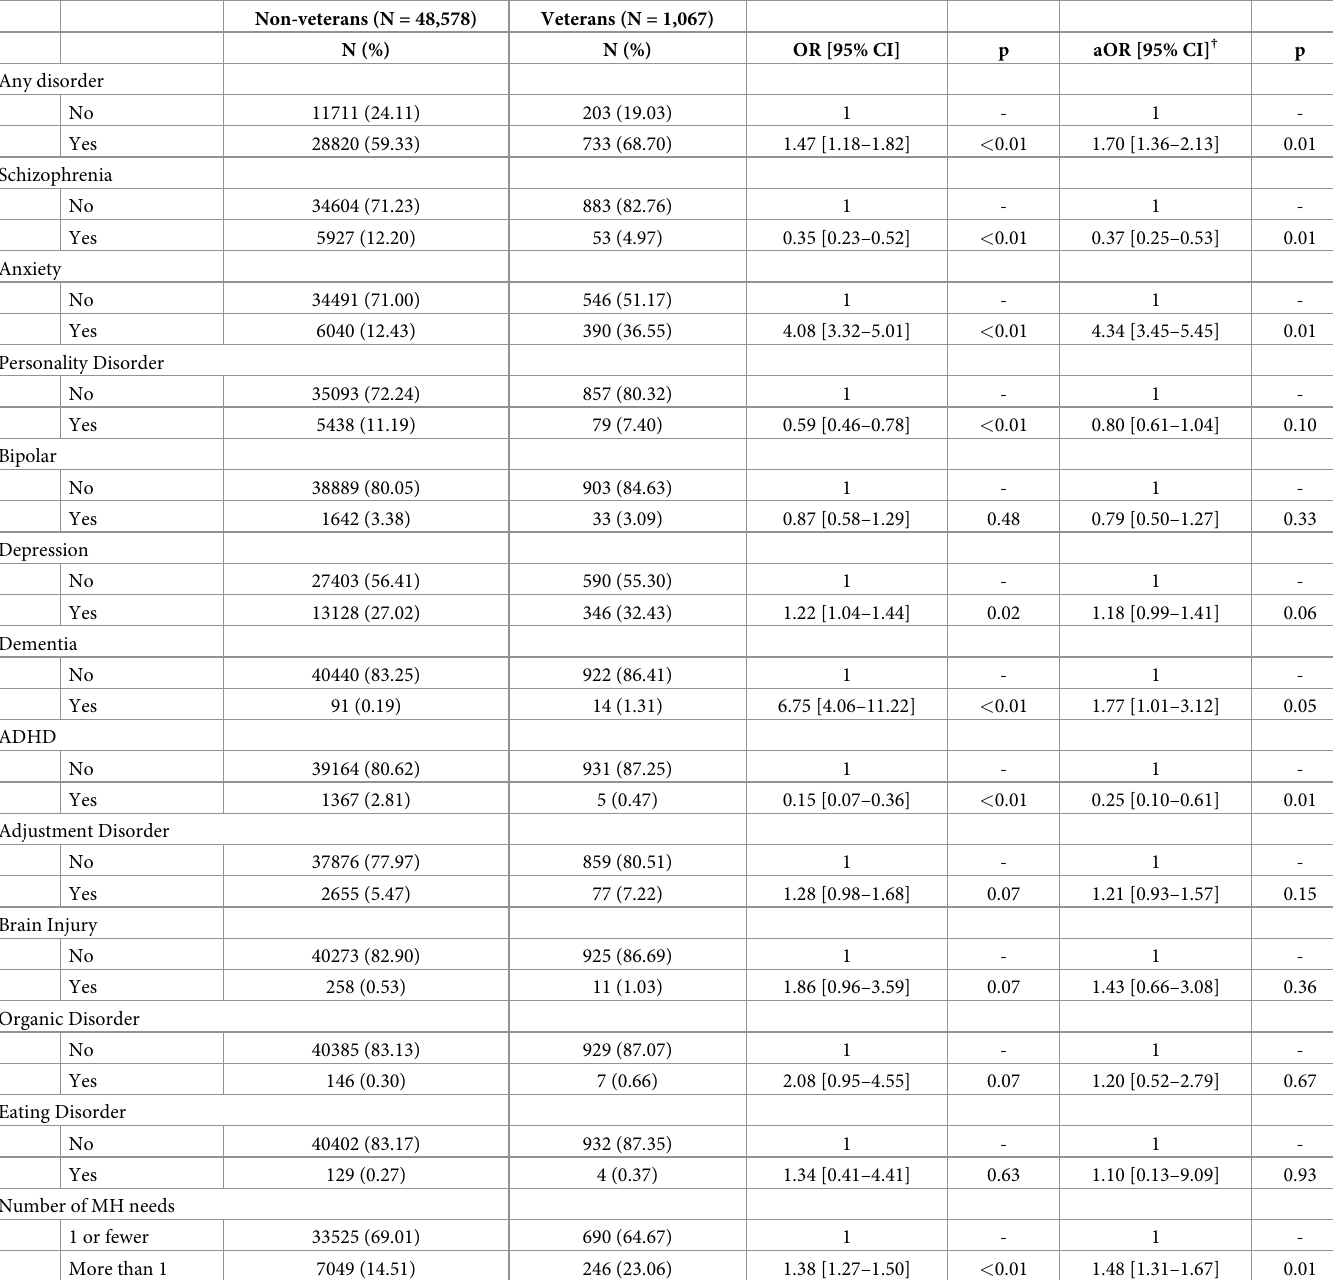
Table 4. Association of mental health needs with veteran status. Non-veterans (N =